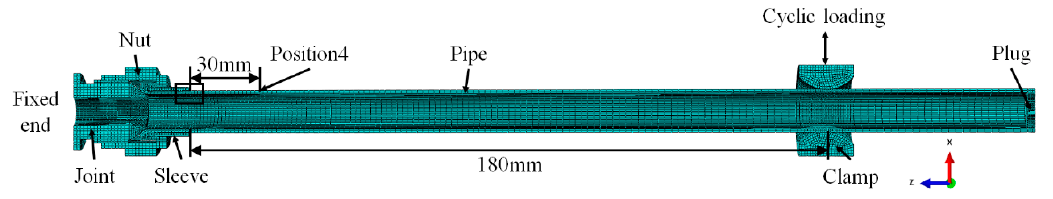
Figure 3. Finite element model.